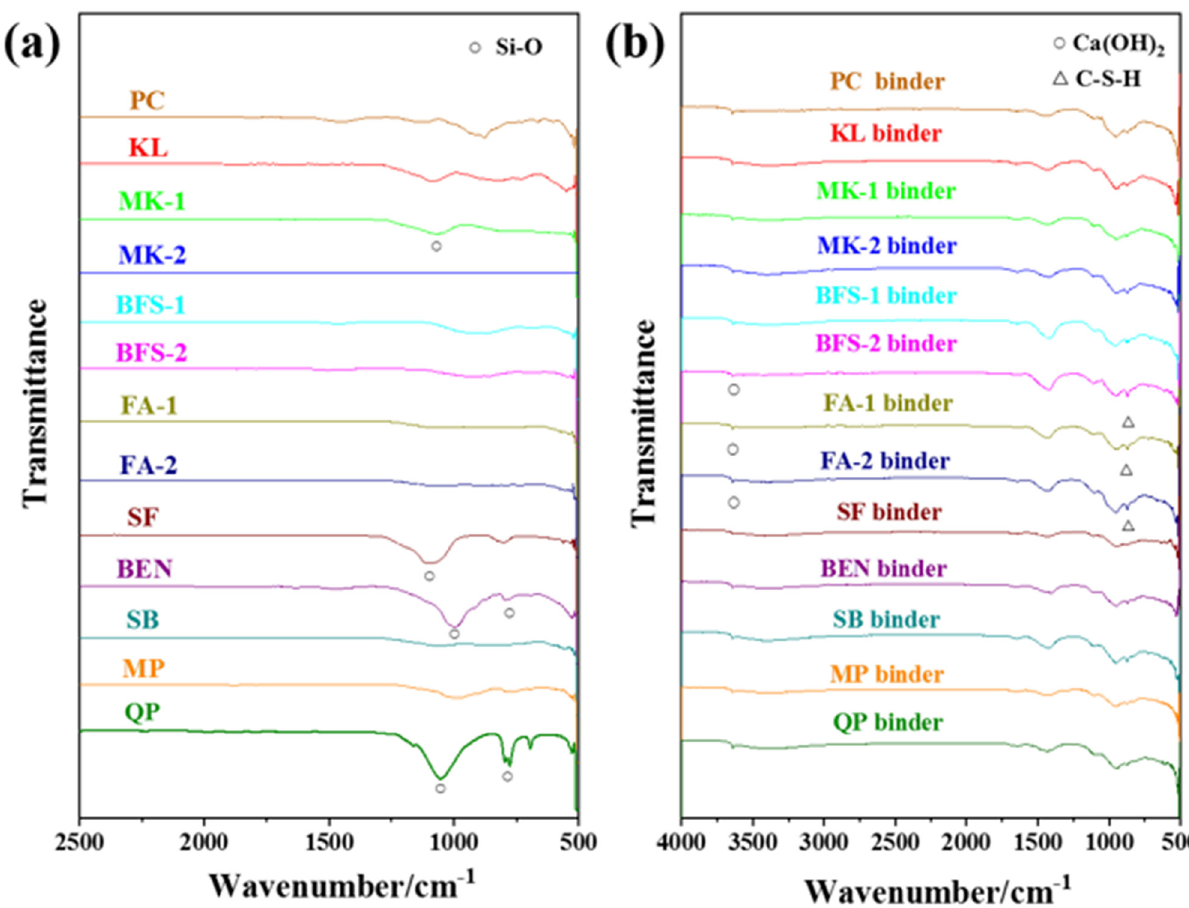
Figure 6: The FTIR spectra of materials: ( a ) raw materials and ( b ) inorganic binders.